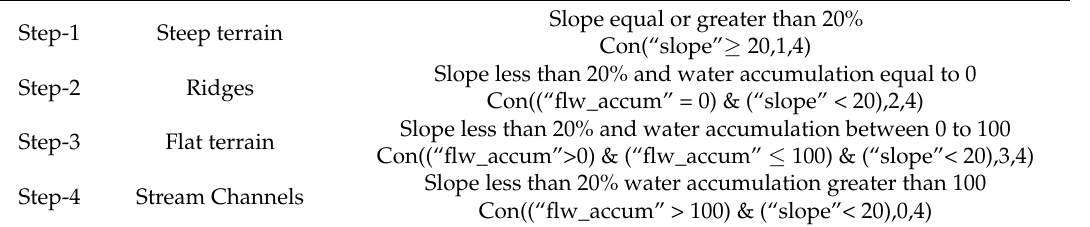
Table 2. Topographic